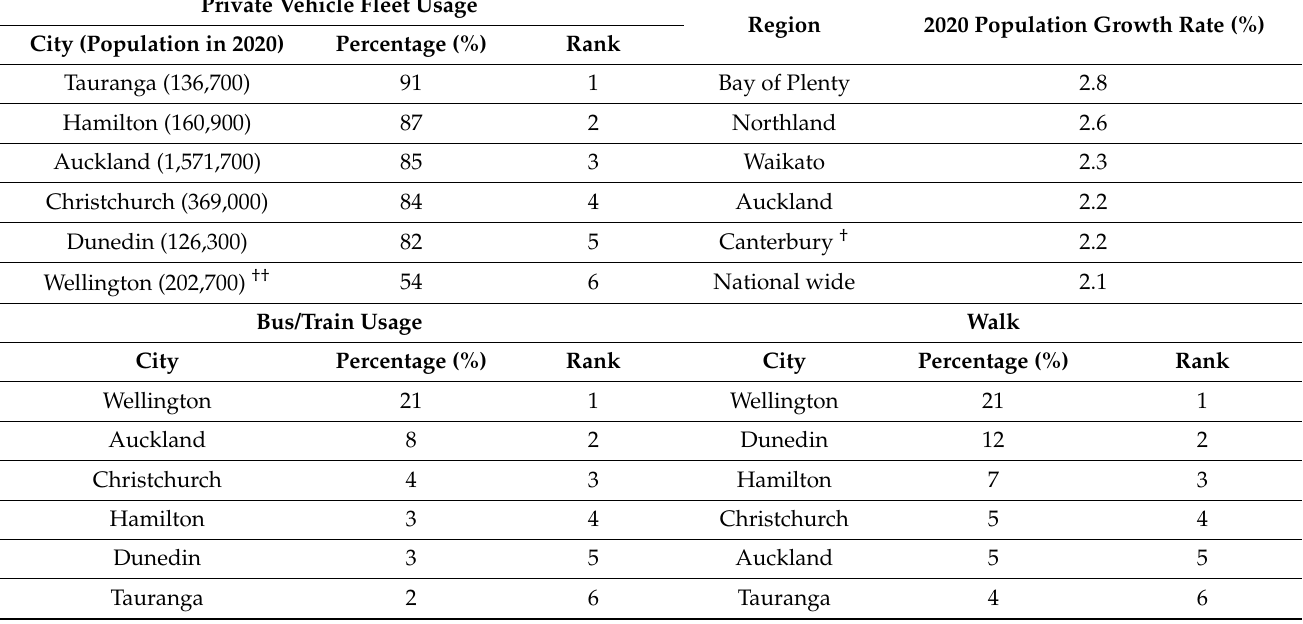
Table A2. Comparison of the ‘means of transportation for daily commute’ among New Zealand’s